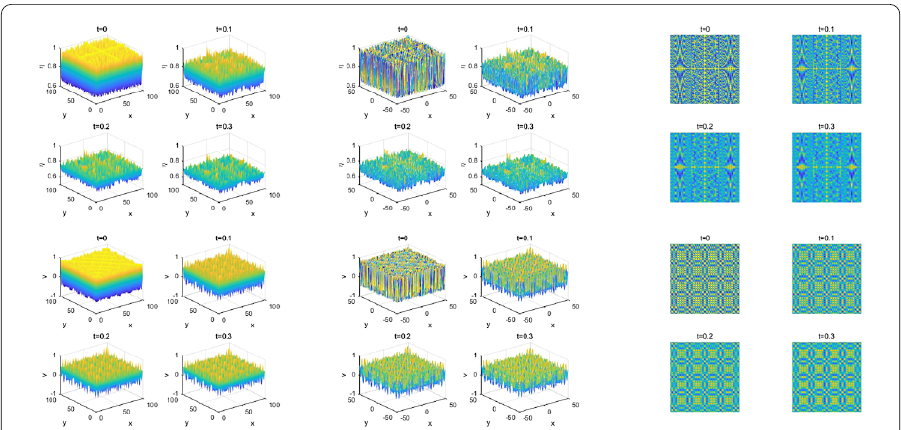
Figure 5 Numerical solution and pattern of Experiment 2, for initial conditions see Table 3